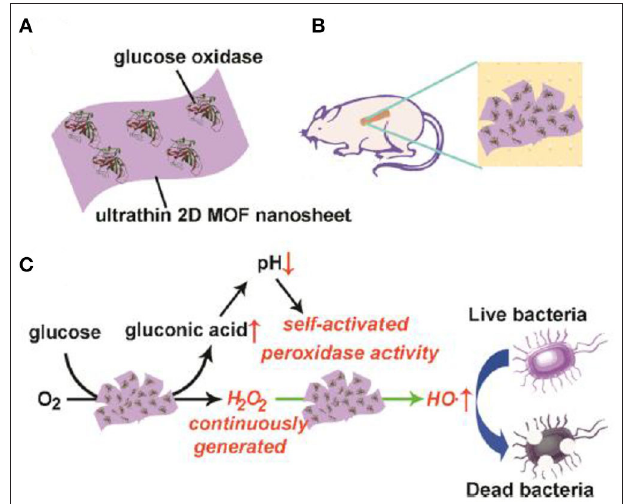
FIGURE 2 | Illustration of (A) composition, (B) use for wound healing of mice, and (C) antibacterial mechanism of 2D MOF/GOx hybrid nanozyme. Reproduced with permission from Liu X. P. et al. (2019). Copyright 2019 American Chemical